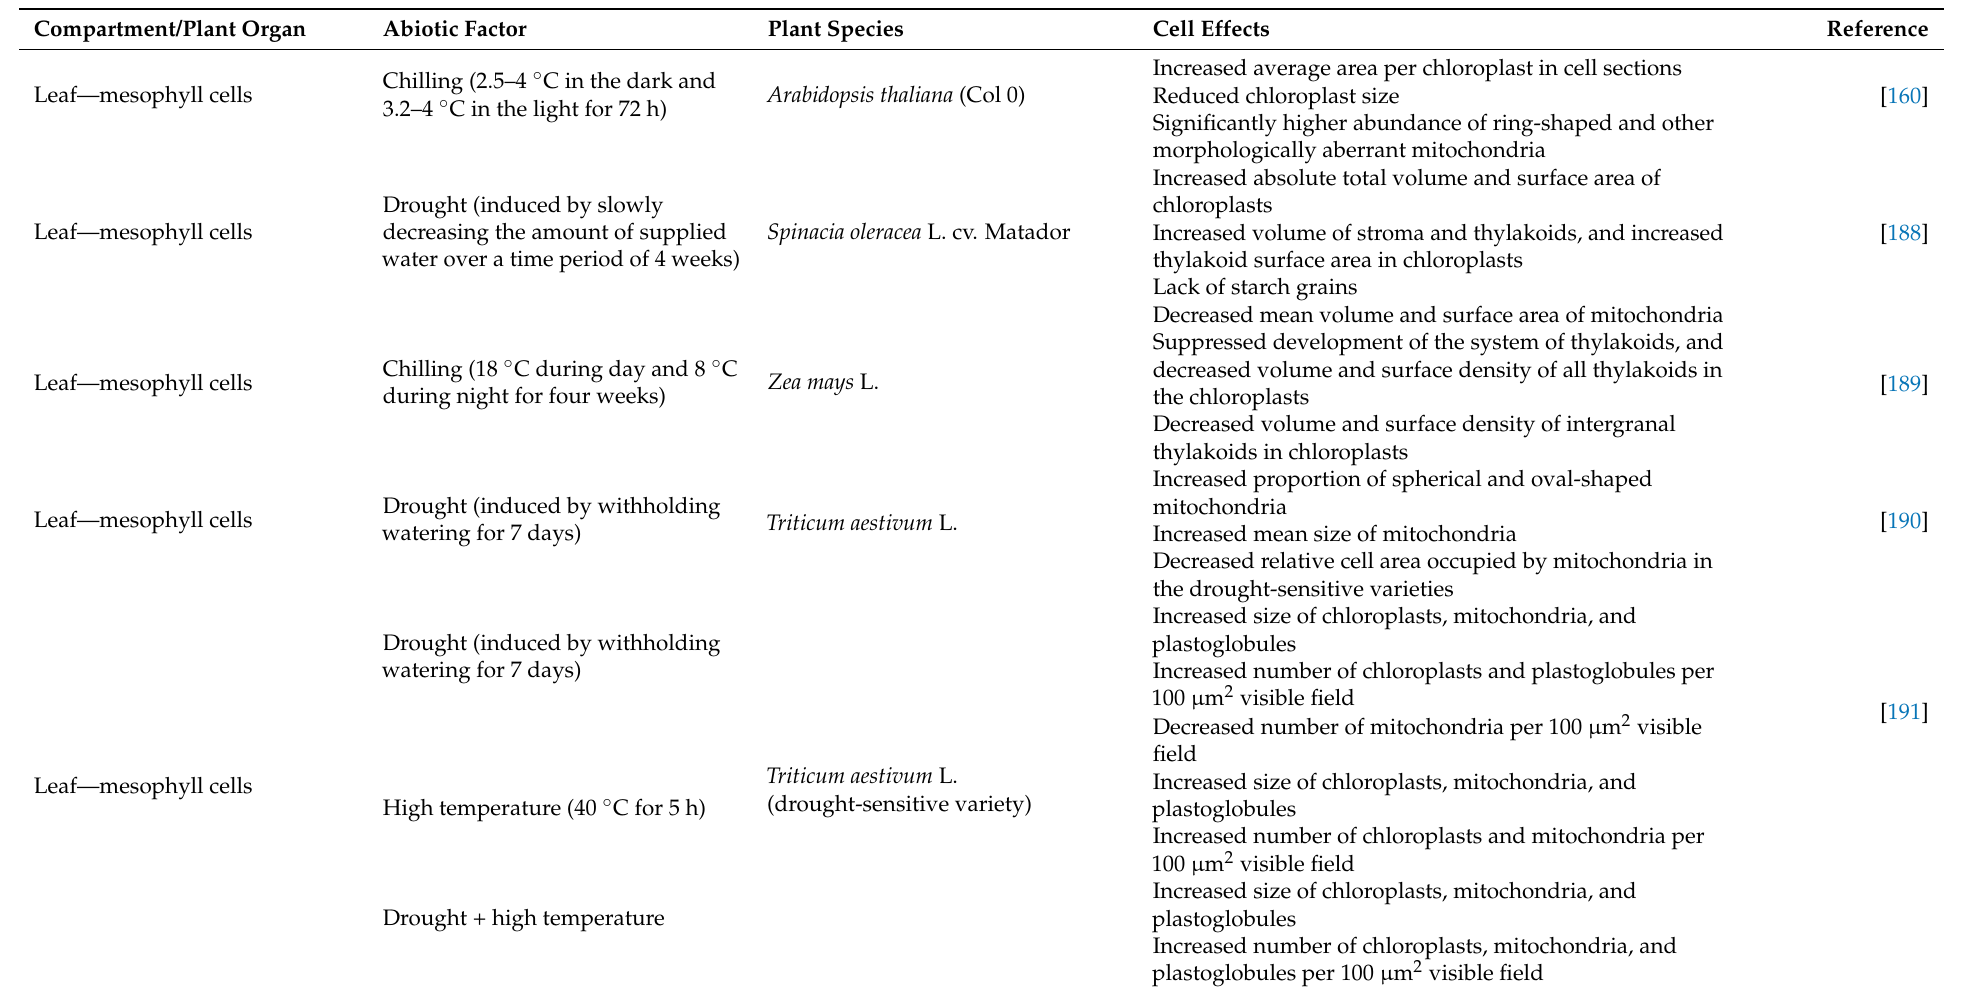
Table 3. Effects of various abiotic stress factors on quantitative ultrastructural characteristics of plant model